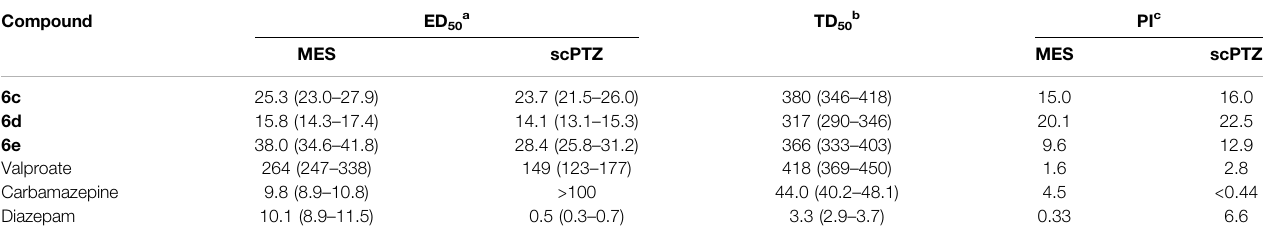
TABLE 2 | Quantitative anticonvulsant date of 6c , 6d , and 6e (anti-MES and anti-PTZ) in mice administered intraperitoneally.